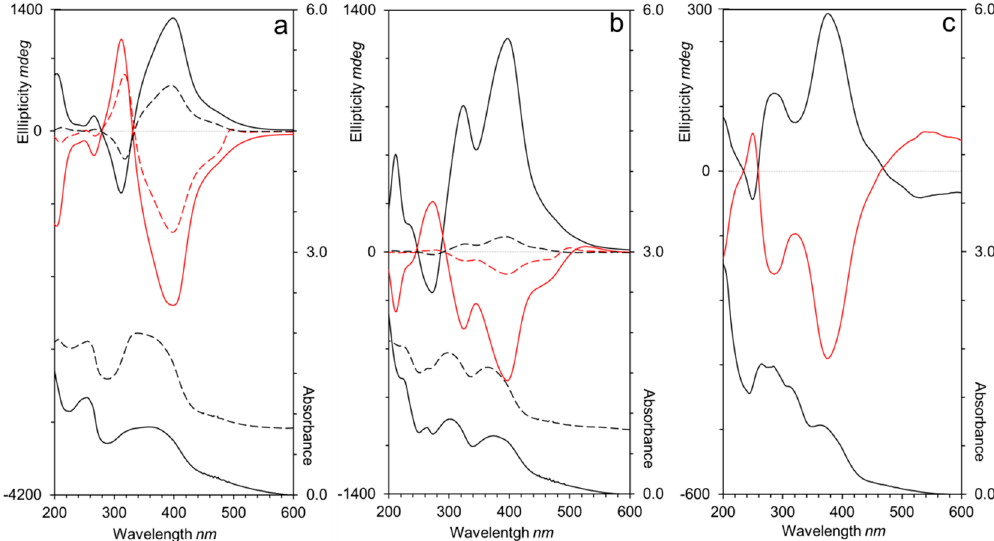
Figure 8. UV–Vis and electronic circular dichroism spectra of ( a ) P 100 (7eAZO/eAZO) and P 40 (7eAZO/eAZO)- b -PMMA800 , ( b ) P 100 (10cCNB/eAZO) and P 40 (10cCNB/eAZO)- b -PMMA800 , and ( c ) P 70 (7cCIN/eAZO) after irradiation with right (black) or left (red) handed CPL. Spectra of the homopolymers are displayed in solid lines and block copolymers in dotted lines.